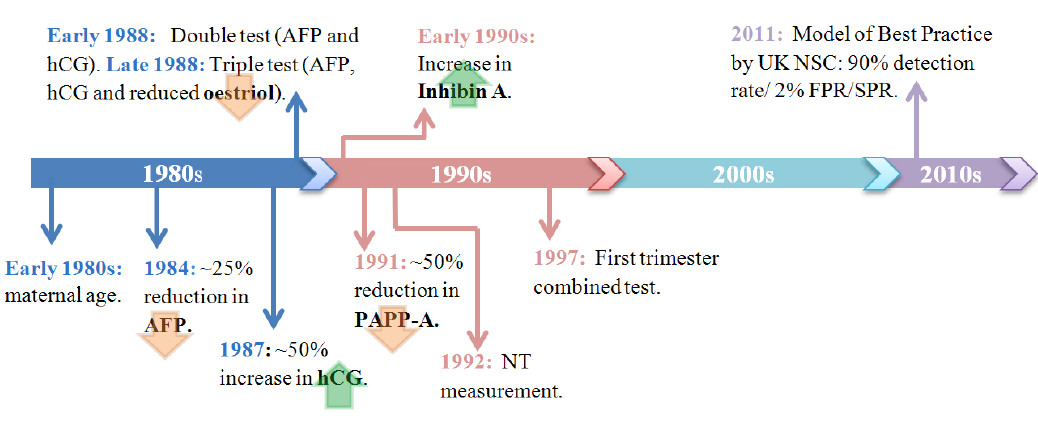
Figure 3. Timeline summarising the key developments in UK DS screening, from the early 1980s when maternal age was effectively the only screening tool used up to the identification of the Model of Best Practice (MoBP) identified by the UK National Screening Committee (NSC) in